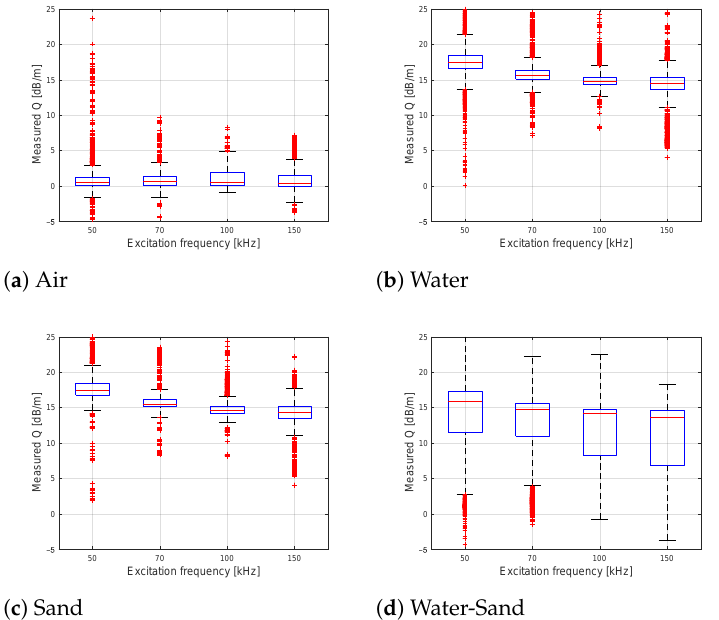
Figure A2. Estimated attenuation rates Q along each phase for the measured energy decays and the known travel distances. The data contains all measured circumferential FA-L(0,1) of ring number one and is specified for each excitation frequency separately. Additionally, the data is selected for propagation paths solely along the given phase (air, water or sand) or phase transition